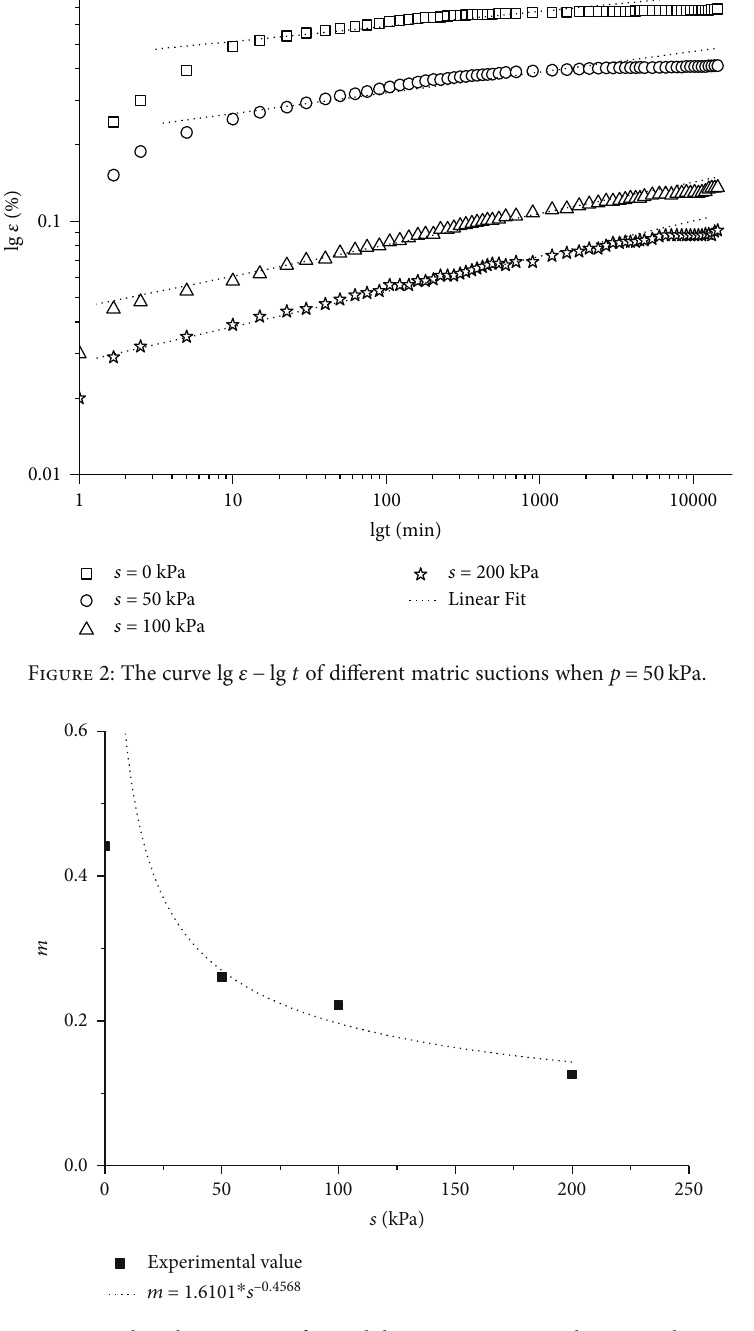
Figure 3: The relation curve of m and the matric suction s when p = 50kPa